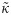
Relation between the kurtosis and the mean trading volume.In the upper left panel we present the scatter plot κ˜
v
μ˜ for 1S06 where the lines correspond to the fits with a second order polynomial for each half of the trading session. For the morning orange line fit we have κ˜=(1.5±0.1)μ˜2-(6.1±0.5)μ˜+(12.2±0.5) whereas for the afternoon pink line fit κ˜=(0.19±0.08)μ˜2-(1.8±0.3)μ˜+(8.5±0.4). The remaining panels present (in counterclockwise direction) the evolution of the second, the first and the constant (order) polynomial coefficients.